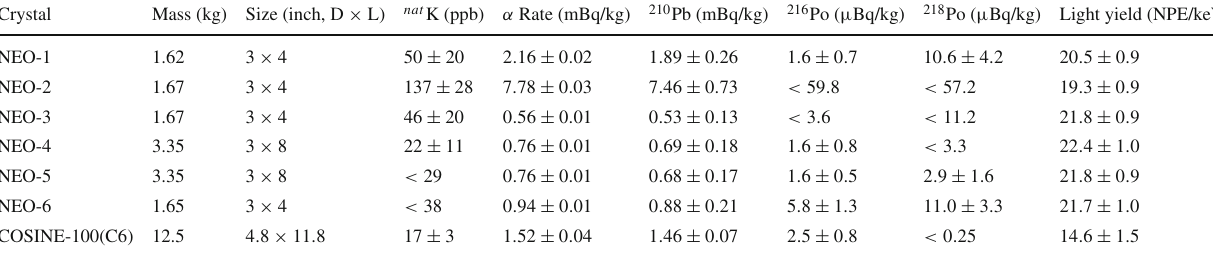
Table 1 Measured radioactivity levels in the NEON crystals with their specifications are compared with one of the COSINE-100 crystals [44]. The light yields are measured with the 59.6keV γ peak from a 241 Am source. The levels of 216 Po and 218 Po are measured by the time coinci- dence measurements of the α particles that are elements of decay chains from 232 Thand 238 Uchain,respectively.Anoveldetectorencapsulation